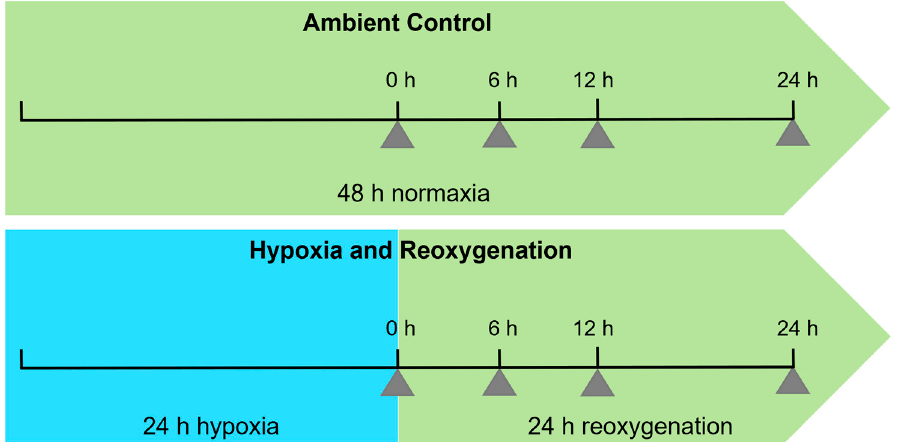
Figure 1. Scheme of the experimental design and time-points of sample collection for transcript and metabolite analyses. For the hypoxia and reoxygenation treatment, Arabidopsis seedlings were exposed to oxygen-depleted air (100% N 2 gas) for 24 h in a hypoxia chamber and sampled after 0, 6, 12, and 24 h upon reoxygenation. The control plants were maintained in an aerated chamber, stayed unstressed throughout the experiment, and were sampled at the same points as the controls.